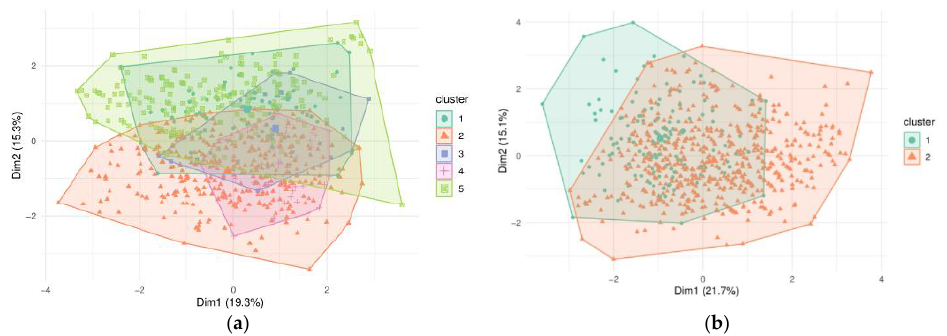
Figure 13. Representation of ( a ) five clusters of the first k-means analysis identified based on geographical position corresponding to the five Campania provinces (1 = Salerno, 2 = Caserta, 3 = Benevento, 4 = Avellino, 5 = Napoli) and ( b ) two clusters obtained from the second analysis. The clustering analysis was repeated excluding the postcode variable. The highest